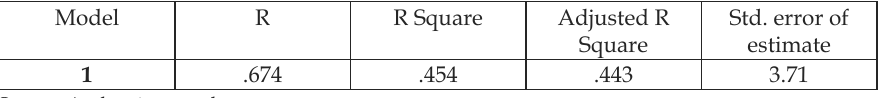
Tab. 9. Predictors of the tendency to leave the organization for the respondents above 35 years. Model summary.